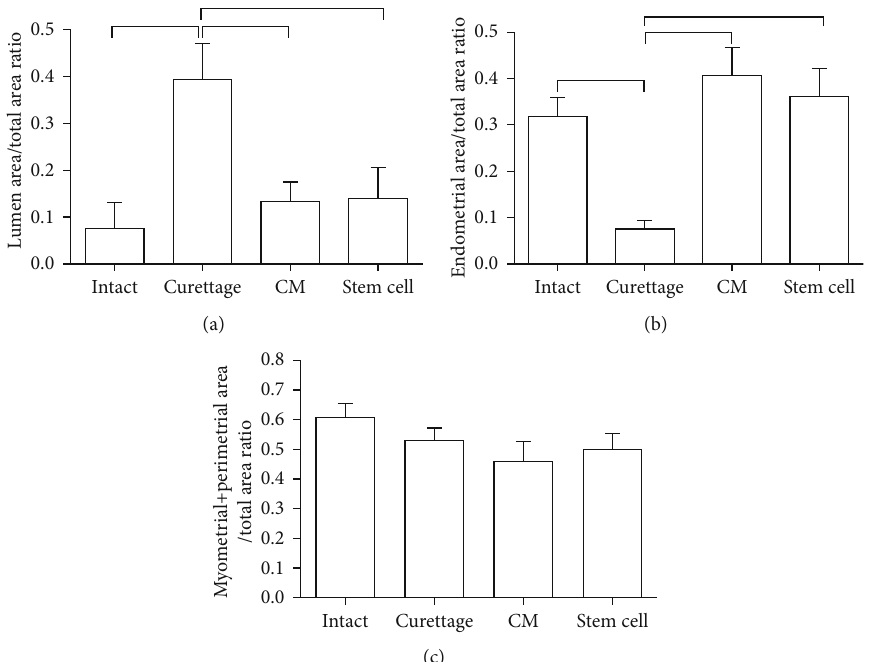
Figure 6: Mean and standard error of the uterine histomorphometric indices to compare the preventive e ff ects of intrauterine bone marrow- derived mesenchymal stromal cell- (BM-MSC-) conditioned media (CM) injection on uterine fi brosis after endometrial curettage in rabbit. (a) Lumen area/total area ratio. (b) Endometrial area/total area ratio. (c) Myometrial + perimetrial area/total area ratio. The horizontal lines above the columns show a statistically signi fi cant di ff erence ( P < 0 : 05 ).